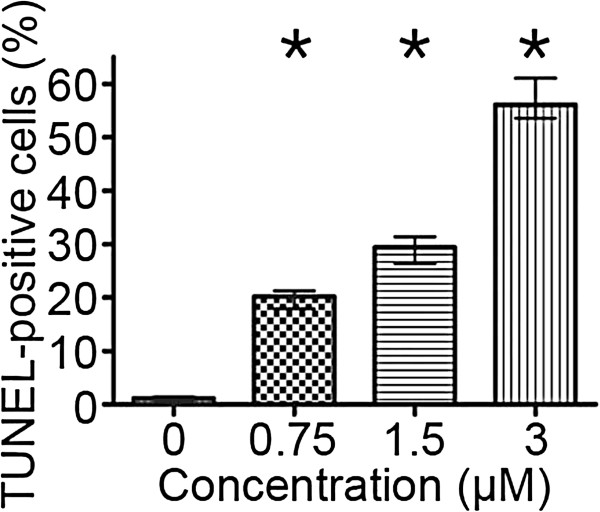
DNA fragmentation rate in A549 cells after treatment with etoposide - statistical data from flow cytometric analyses (the TUNEL method). Statistically significant differences as compared to the control cells are marked by asterisks (Mann–Whitney U statistics, P<0.05). Columns - median percentage of cells, bars - interquartile range. Results are representative of five independent experiments.